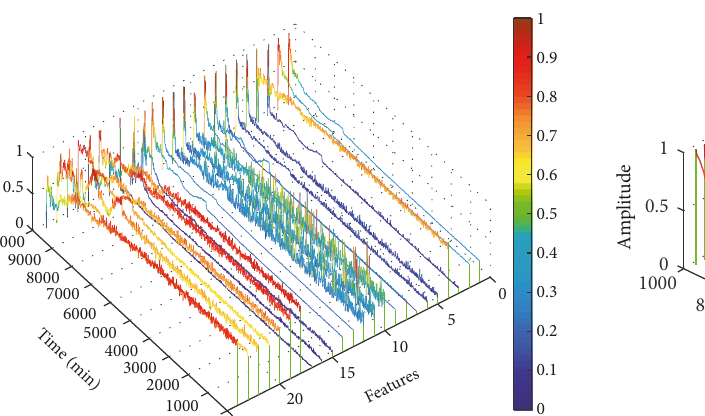
Figure 11: Waterfall of cumulative features.